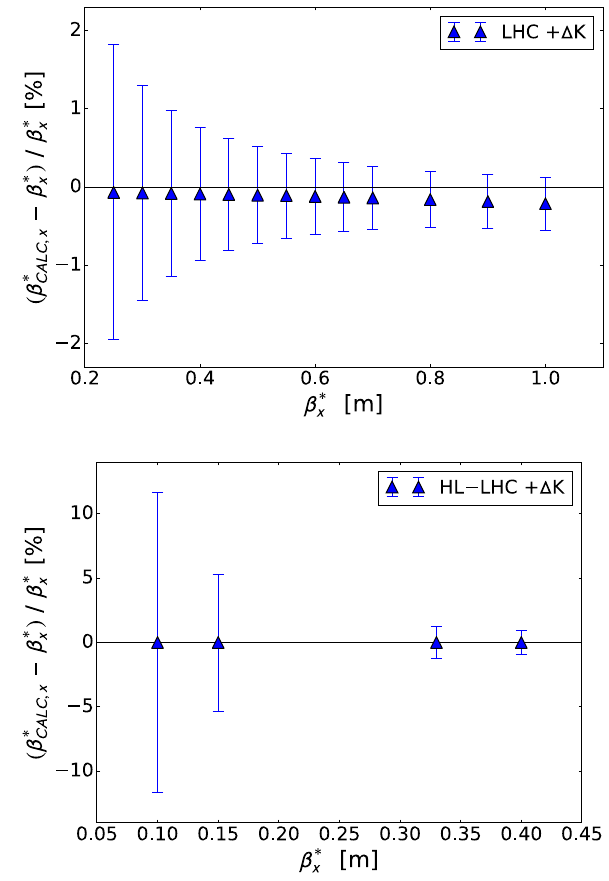
FIG. 6. The calculated β (cid:1) calc using the new analytical method in the LHC (top figure) and HL-LHC (bottom figure) including the effect of fringe fields on the last quadrupoles. Results are presented for the horizontal